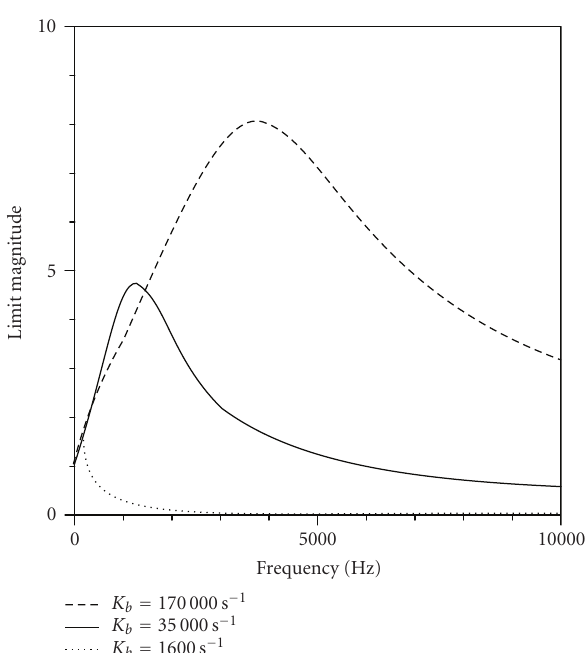
Figure 6: Frequency response of AP/HTPB Propellant B, theory ( K b = 29000 s − 1 , Δ H s = 75000 J/kg) and experiment [23], in terms of real part of pressure-based function (theory & experiment, pres- sure at 1200